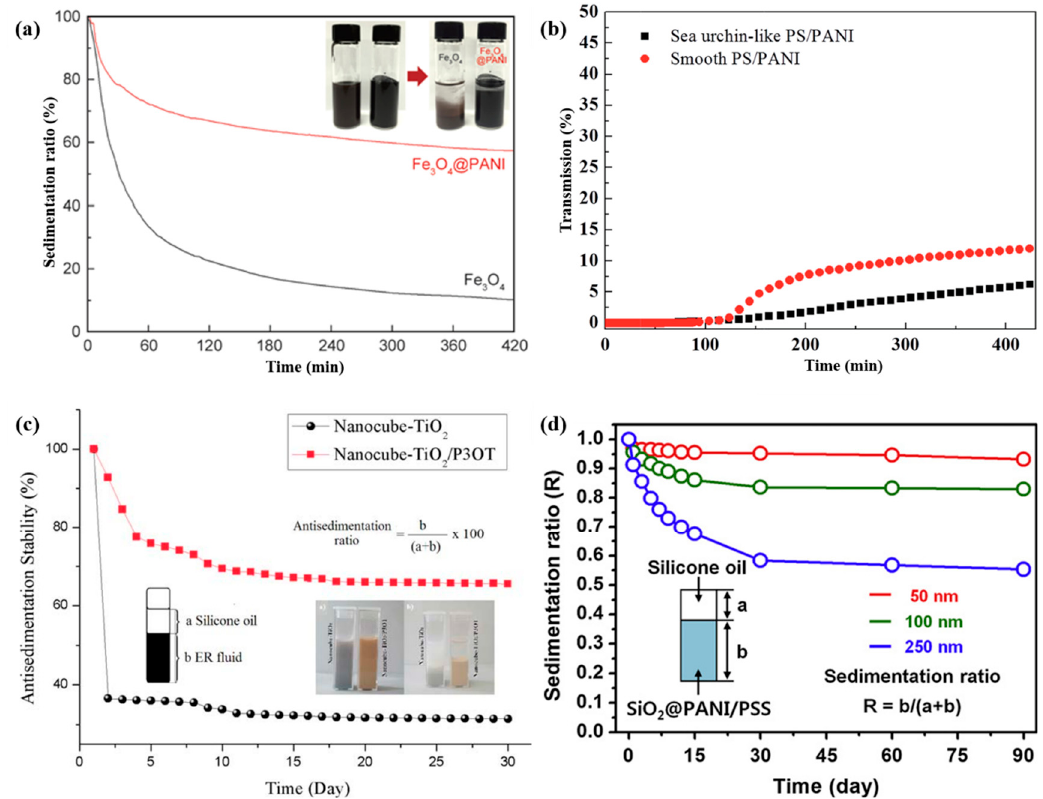
Figure 7. Sedimentation stabilities of suspensions composed by ( a ) Fe 3 O 4 and Fe 3 O 4 /PANI (Sim et al. [72], © BME-PT, 2015); ( b ) smooth PS/PANI and sea urchin-like PS/PANI (Kim et al. [66], © The Royal Society of Chemistry, 2015); ( c ) nanocube-TiO 2 and nanocube-TiO 2 /P3OT (Sever et al. [94], © Society Engineers, 2016); ( d ) PANI / PSS-coated SiO 2 with different size (Lee et al. [70], © Elsevier, of Plastics Engineers, 2016); ( d ) PANI/PSS-coated SiO 2 with different size (Lee et al. [70], © Elsevier, 2013).